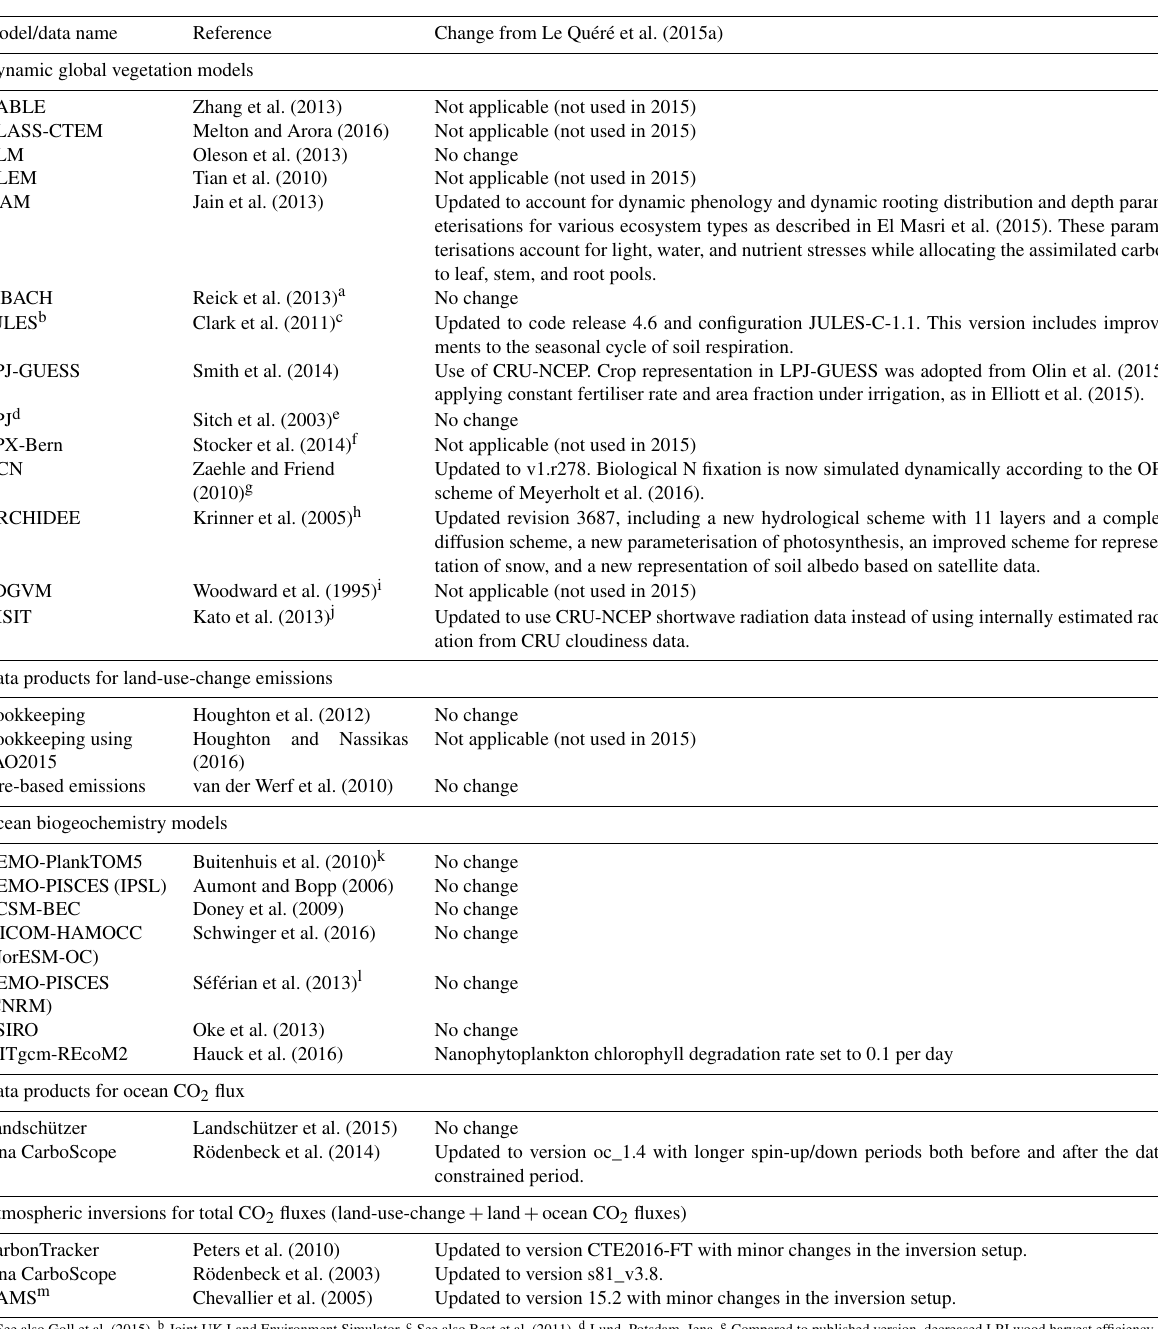
Table 6. References for the process models and data products included in Figs. 6–8. All models and products are updated with new data to end of year